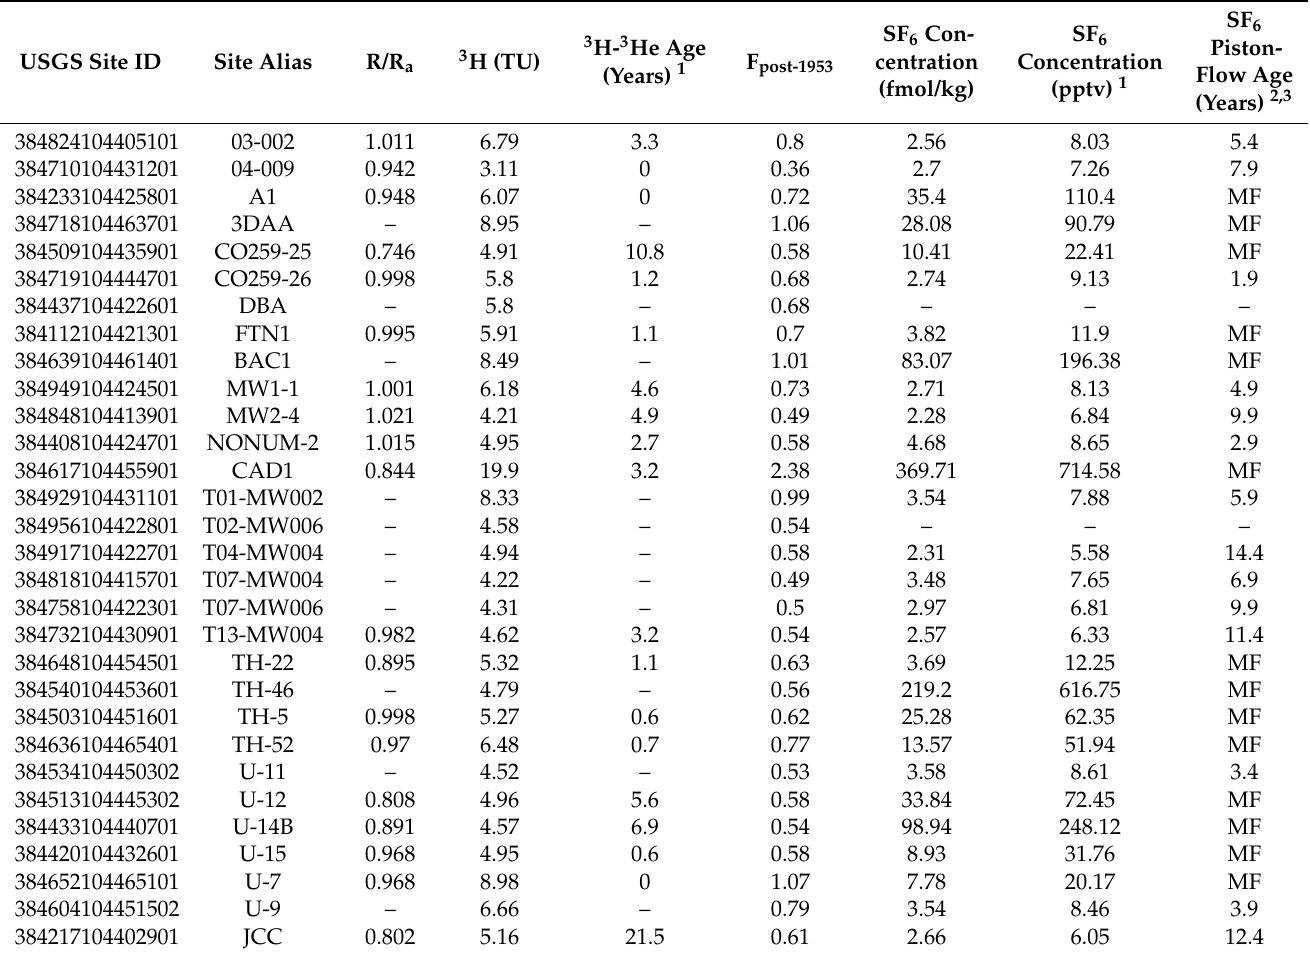
Table 2. Results of apparent-age calculations, concentrations of atmospheric tracer gases, and idealized piston-flow ages of groundwater wells in the Fountain Creek alluvial